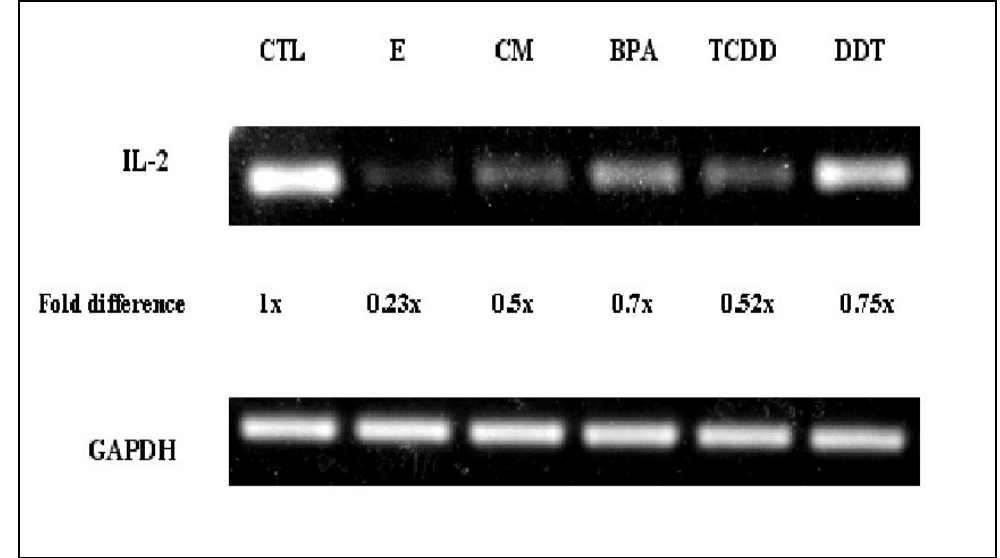
Figure 2. Semi quantitative RT-PCR of IL-2 mRNA transcripts from activated Jurkat T cells at 18 hrs in control (C) vs. 17- β -estradiol , coumestrol, bisphenol A, TCDD, and DDT exposed cells (10 -6 M). GAPDH is used as a housekeeping gene. One representative experiment (n = 3) is shown. MRNA transcripts were variably suppressed (0.2-0.75x of control) in 17- β -estradiol, coumestrol, BPA, TCDD, and DDT exposed Jurkat T cells compared to control (1x).